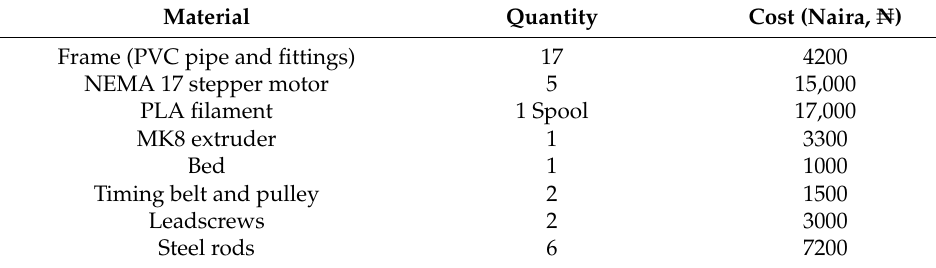
Table 3. The bill of engineering material and